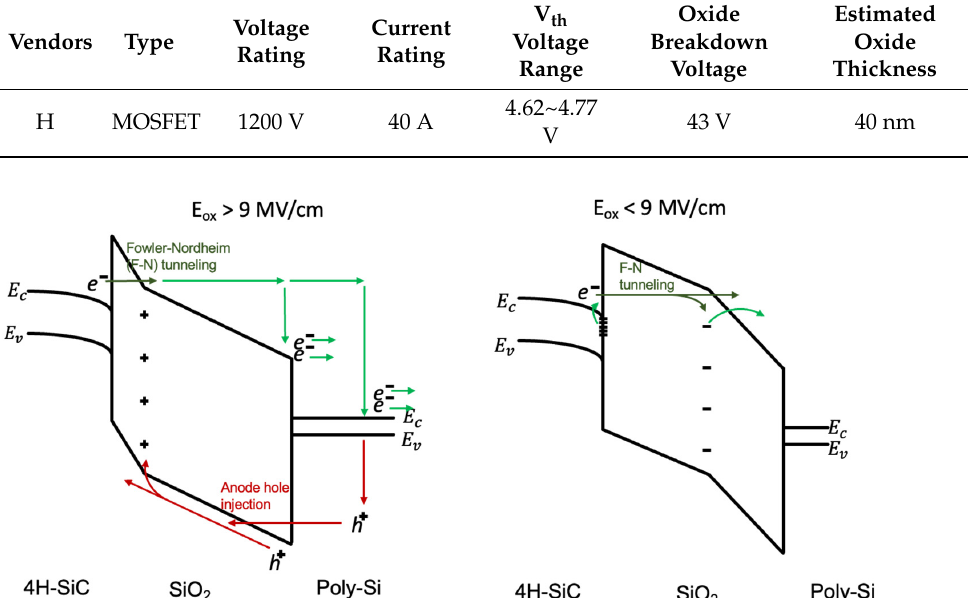
Figure 14. ( a ) Weibull distribution at 150 °C with different gate biases; ( b ) predicted failure times [17]. 2.5. Body Diode Reliability One of the major concerns in the implementation of high voltage SiC MOSFETs is the degradation of the internal body diode. Despite breakthroughs in SiC wafer technology and device processing, basal plane dislocations (BPDs) have always been an issue. The BPDs may originate in the substrate [25], or be created during the growth of epilayer [26], or may be created by certain steps during the device fabrication [27]. Stahlbush et al. re- ported recently that implantation of high-dose Aluminum (Al) at room temperature re- sults in BPDs [28]. The stacking faults (SFs) are activated due to the energy produced by the recombination of electron–hole pairs in a forward-biased body diode. The carrier life- time also decreases due to the SFs resulting in an increase in the forward voltage drop of the body diode [29]. The effect of SFs on the on-resistance and the forward leakage current in a 10 kV SiC MOSFET [30] was first reported by Agarwal et al. in 2007. The body diodes are expected